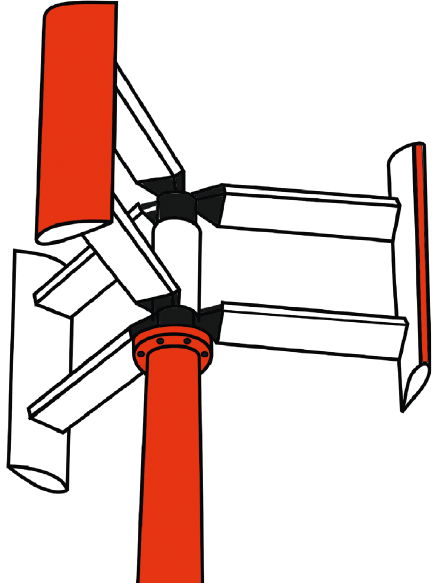
Figure 1: Straight rotor of Darrieus wind